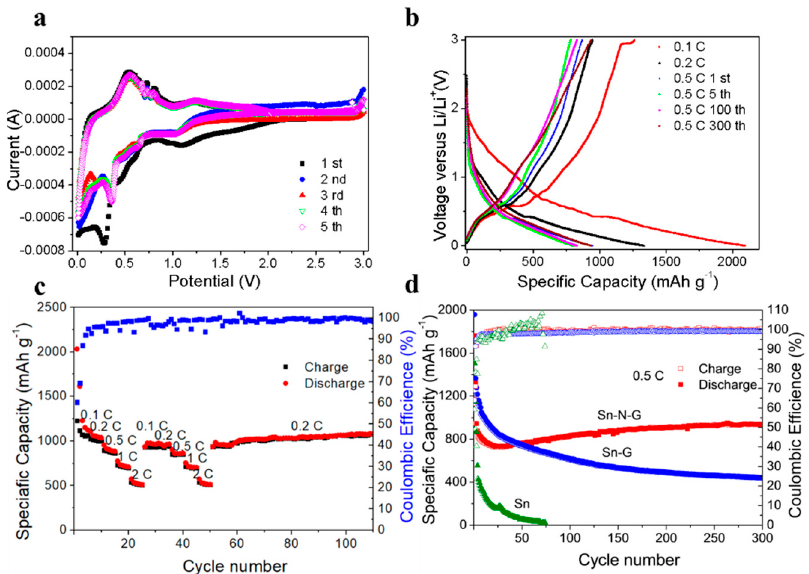
Figure 4. ( a ) Charge-discharge curves of the Sn@N-G anode at different current densities. ( b ) Cyclic voltammetry (CV) curves of the Sn@N-G anode at a scan rate of 0.1 mV/s. ( c ) Rate capability of the Sn@N-G anode. ( d ) Cycling performance comparison of Sn, Sn-graphene, and Sn@N-G electrodes.